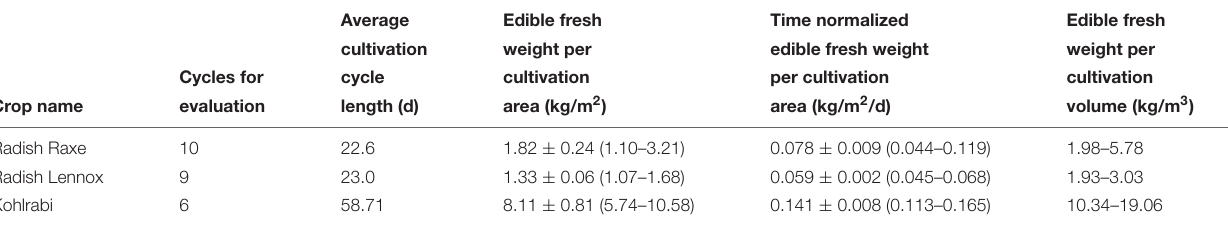
TABLE 9 | Tuber crops edible fresh weight production